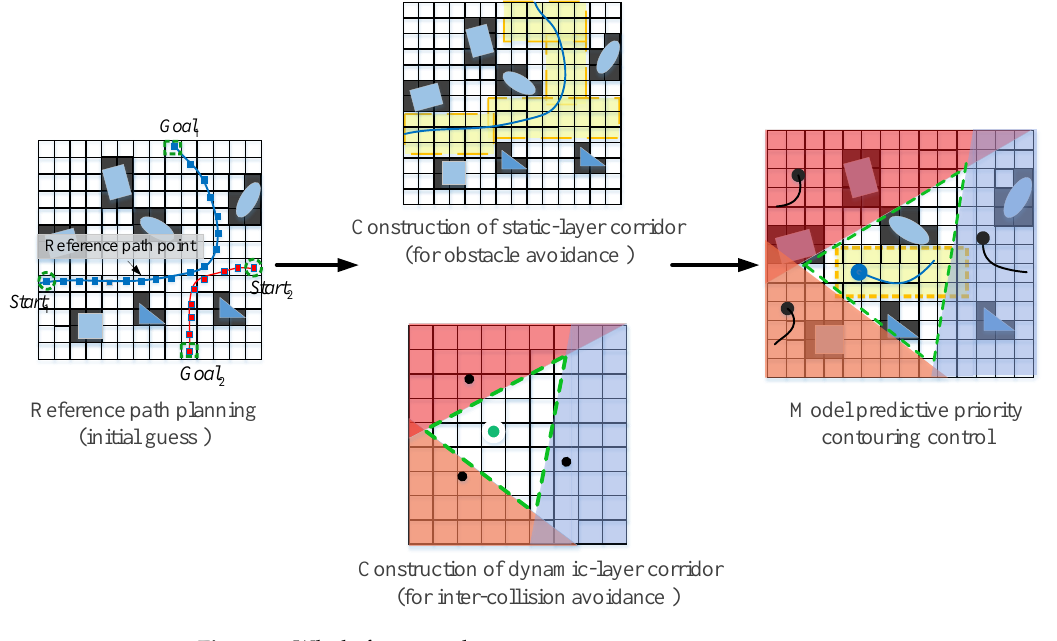
Figure 3. Whole Figure 3. Whole framework